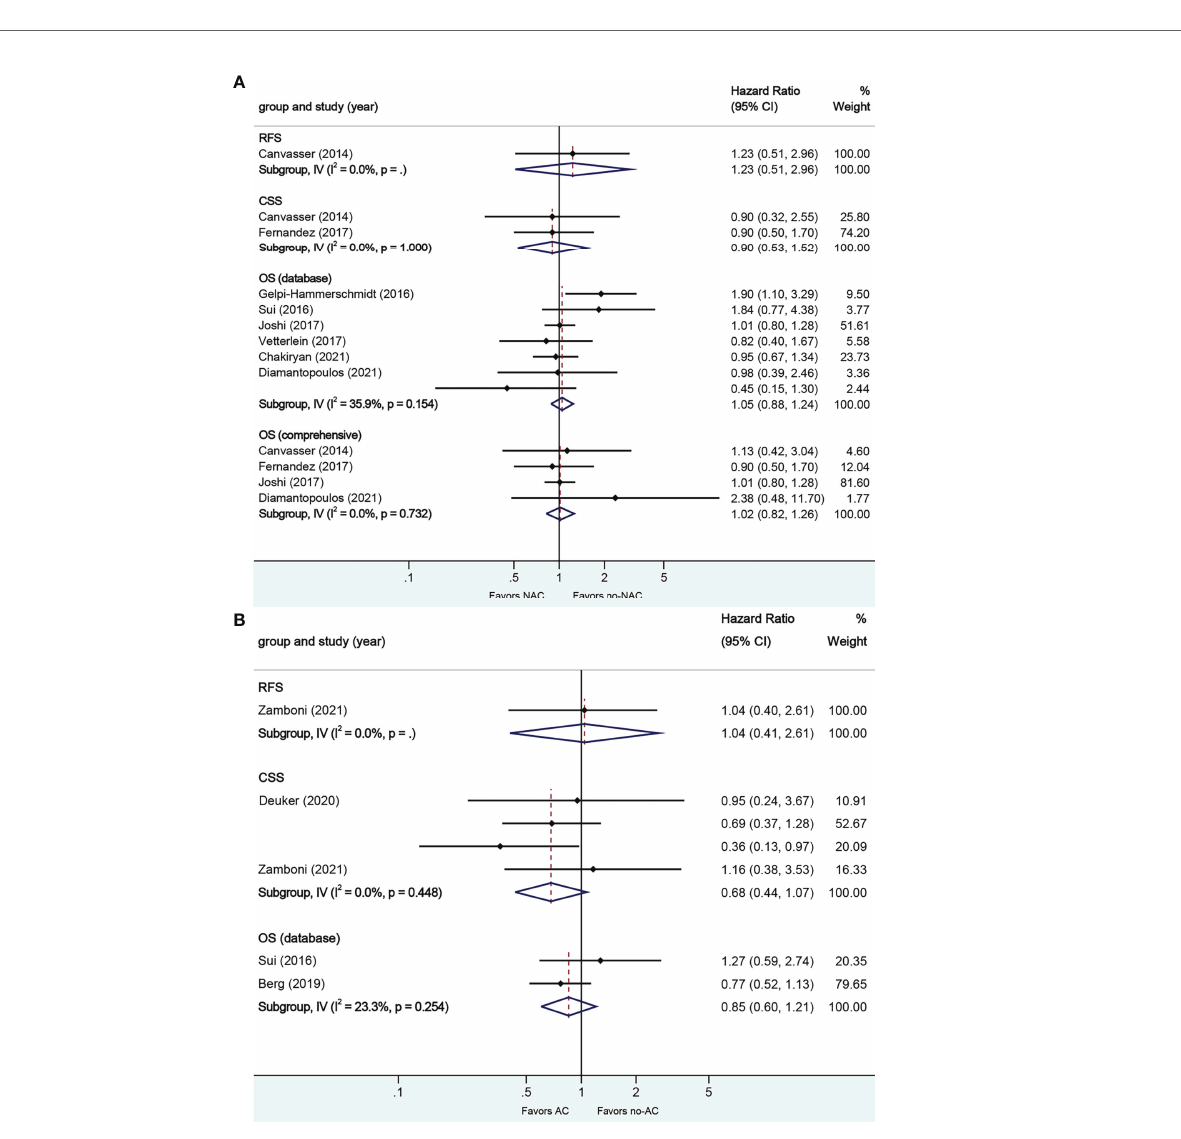
FIGURE 4 | Forest plots of studies investigating the association of chemotherapy with survival outcomes in micropapillary variant histology. (A) neoadjuvant chemotherapy; (B) adjuvant